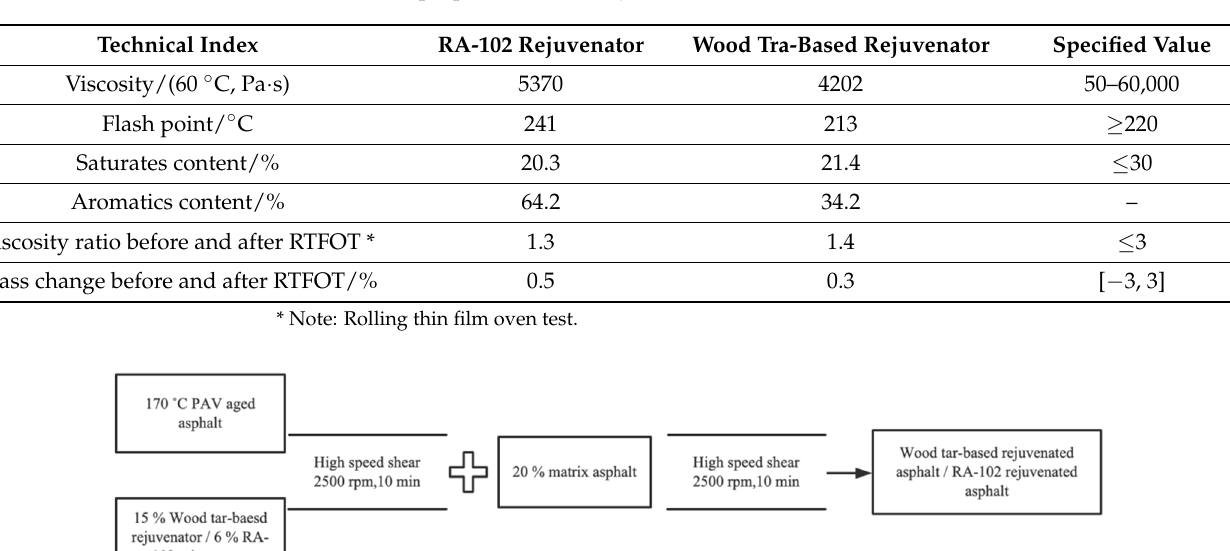
Table 3. Basic properties of each rejuvenator [13].